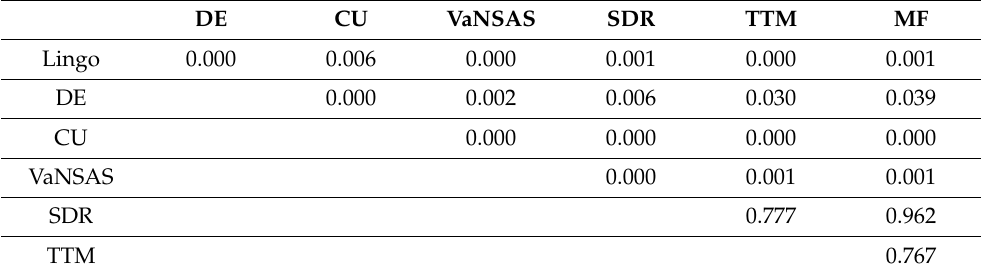
Table 12. Statistical test of objective function for medium-sized